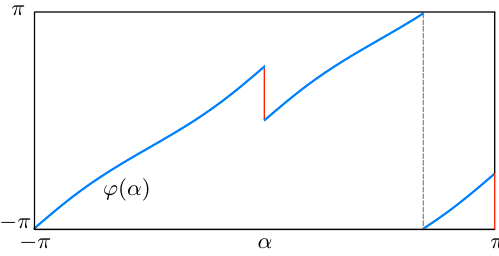
Figure 6 . The phase ϕ ( α ) mod 2 π , given by (4.28) together with (4.6), (4.30), plotted as a function of α in the case e λ = 1 / 2 . Note the discontinuities at α = 0 and α = π marked by the red vertical